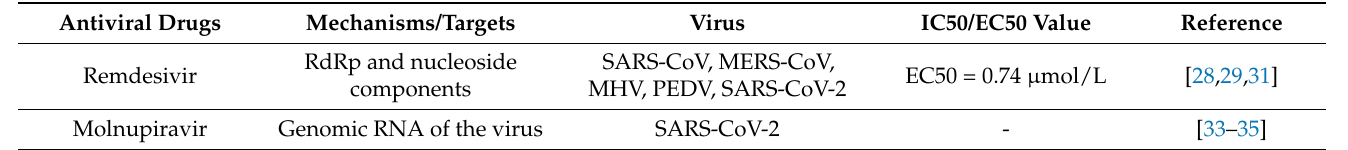
Table 1. Antiviral nucleoside analogs and the antiviral